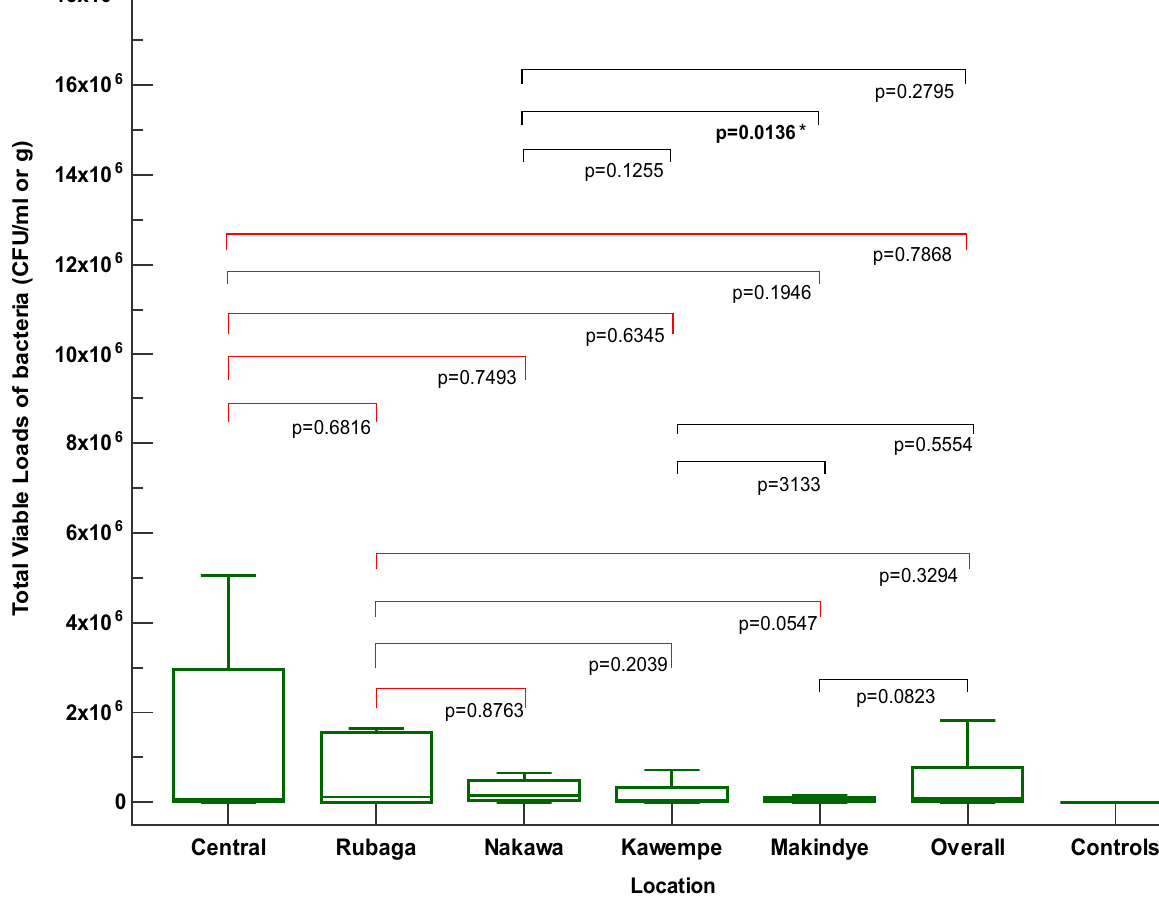
Figure 3. Distribution of total viable loads (TVL) of bacteria in herbal medicines sold in Kampala. The p values show the significance of differences in TVL in the five divisions of the city, viz; Kampala central, Rubaga, Nakawa, Kawempe, and Makindye (p <